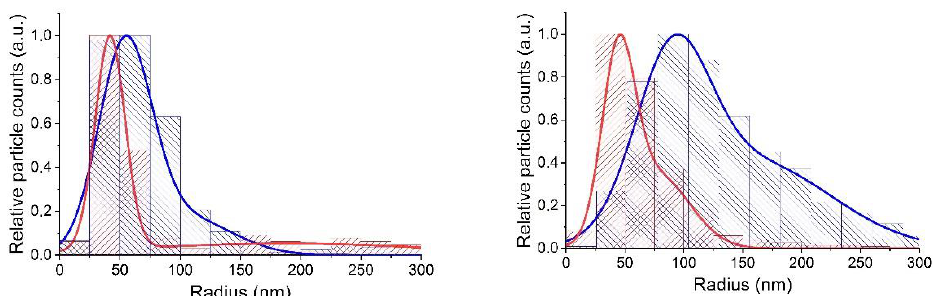
Figure 5. Size distributions of the colloidal solution of LaF 3 :Nd 3+ nanoparticles in deionized water, measured with the ultramicroscope, 3 days ( left panel ) and 7 months ( right panel ) after sample preparation. Blue — data obtained without applying ultrasonic treatment to the colloidal solution, red — after 20 min of such exposure.